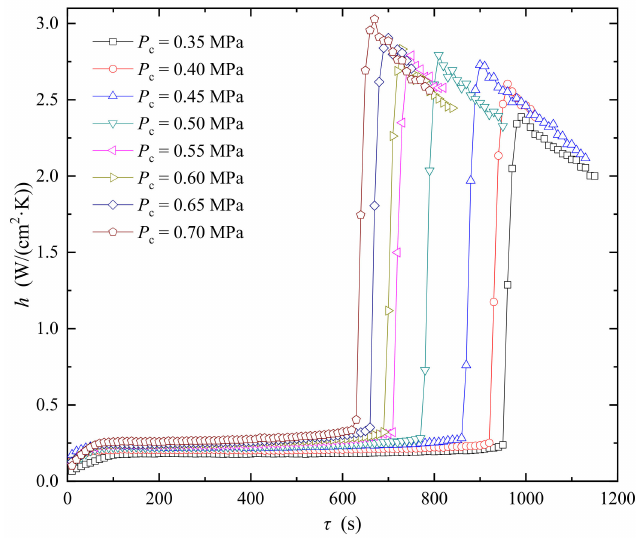
Figure 13. Curves of heat transfer coefficient with time during the dissipating process.